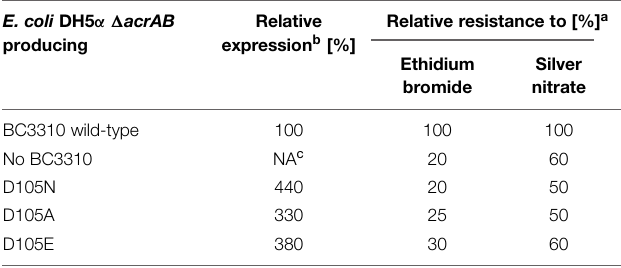
TABLE 3 | Relative expression rate and relative MIC of E. coli strains producing no BC3310, BC3310 wild type, D105N, D105A, or D105E mutant